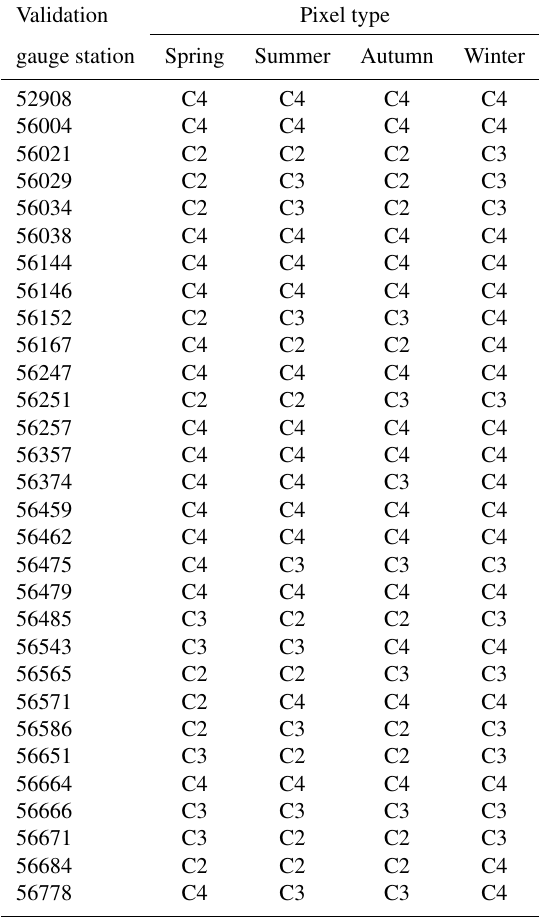
Table D1. Pixel type of the validation gauge